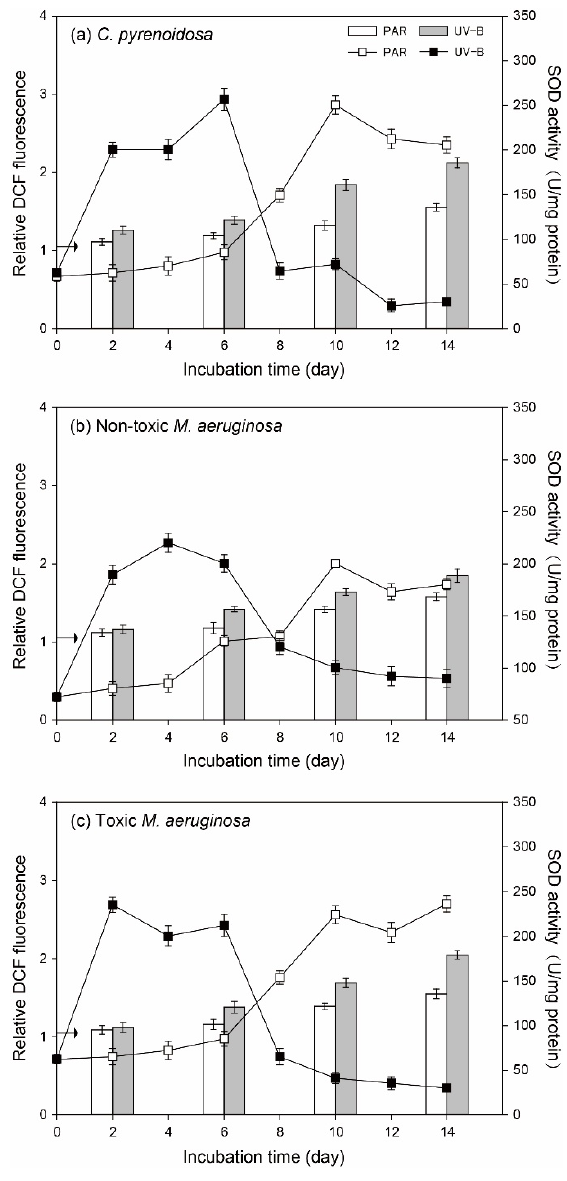
Figure 6. ROS in the cells of three species (vertical bar) and algal SOD activity (line and scatter) during the incubation in the PAR and UV ‐ B treatments under normal growth conditions (the arrow indicates the initial value of ROS contents).